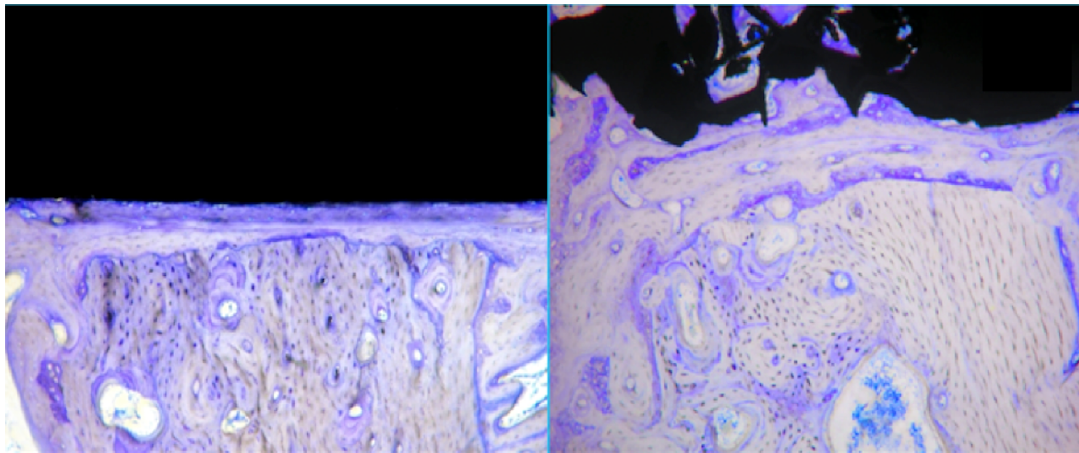
Figure 7. Bone-implant interface at 8 weeks: a) osseointegration and new bone formation at the interface of dense implants (original magnification 10x); b) bone in-growth into a porous surface titanium sample (original magnification 10x).